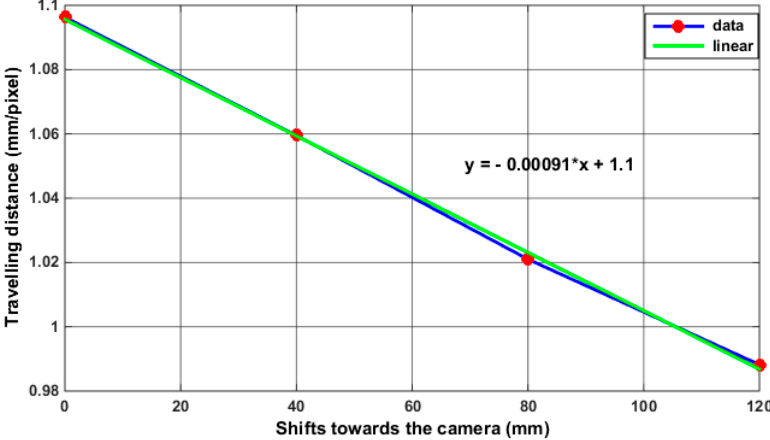
Figure 9. Camera setups in the experiment. The figure shows that the geometric relationship between the travelling distance (mm/pixel) and the changing depth (mm) is linear. We estimate the error in the fit at these points is just 10 microns